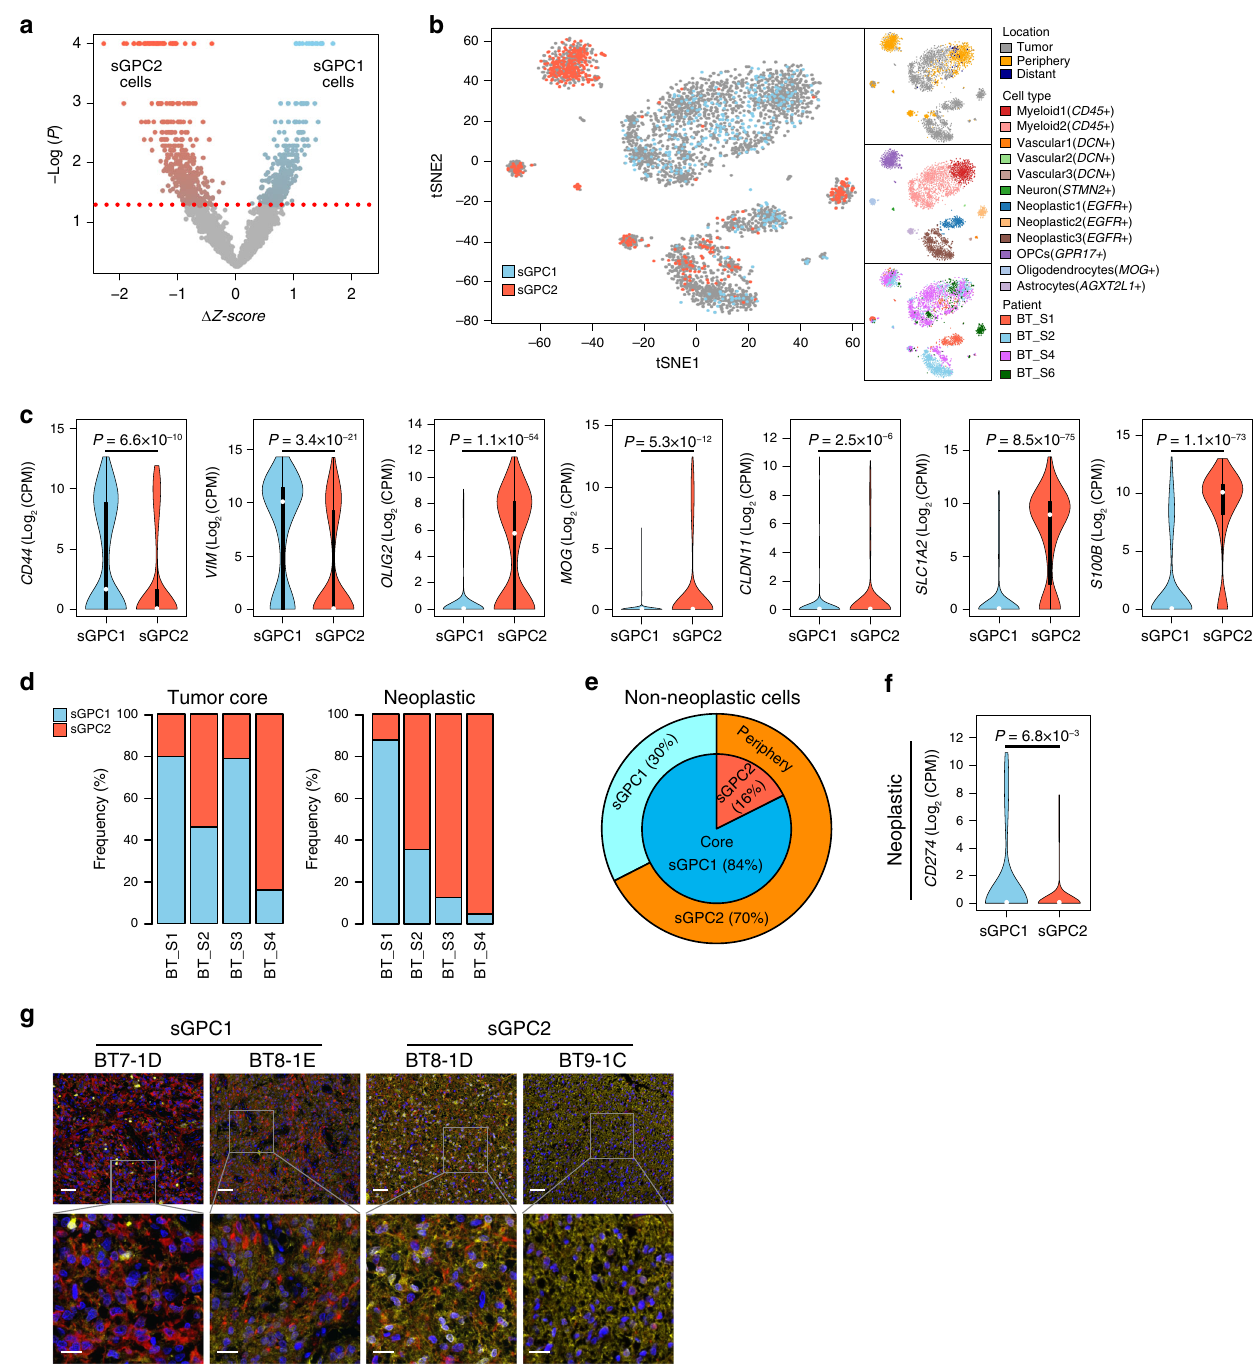
Fig. 5 Classi fi cation of GBM single cells reveals tumor-layer-dependent and cell-type-dependent characteristics of GPC-subtypes. a Classi fi cation of GBM single cells from the data set reported in Darmanis et al. 31 . The red dotted line indicates the statistical threshold used to determine the surrogate GPC (sGPC) subtype of single cells. b 2D t-SNE projection of single cells of surrogate-proteomic subtypes. t-SNE coordinates, single-cell annotations describing the location within the 3D tumor mass, cell type, and the patient origin (shown in right side panels) were obtained from Darmanis et al. 31 . c Subtype-speci fi c mRNA expression of neural stem cell (NSC), oligodendrocyte, and astrocyte markers in single cells. CD44/VIM, OLIG2/MOG/CLDN11, and SLC1A2/S100B represent NSC, oligodendrocyte, and astrocyte markers, respectively. The violin plots represent density distributions. The description of box and whisker plots in violin is the same as in Fig. 3b. P- values were obtained by two-sided unpaired Wilcoxon rank-sum test. d Proportion of tumor core single cells (left) and neoplastic single cells (right) of two subtypes in four specimens in the data set generated by Darmanis et al. 31 . e Proportion of non-neoplastic single cells of two subtypes in the Darmanis et al. 31 data set. f Subtype-speci fi c mRNA expression of an immune checkpoint ligand CD274 (PD-L1) in neoplastic single cells. The description of the violin plot is the same as in c . P -values were obtained by two-sided unpaired Wilcoxon rank-sum test. g Representative images ( N = 1) of multiplex fl uorescent immunohistochemistry analysis of SMC-TMA samples using PHGDH (yellow) and Nestin (red) antibodies. Nuclei were stained with DAPI (blue). Sample IDs and their respective sGPC-subtypes are indicated above the image. Scale bars: 50 μ m (upper panels), 20 μ m (lower panels). Source data are provided as a Source Data fi